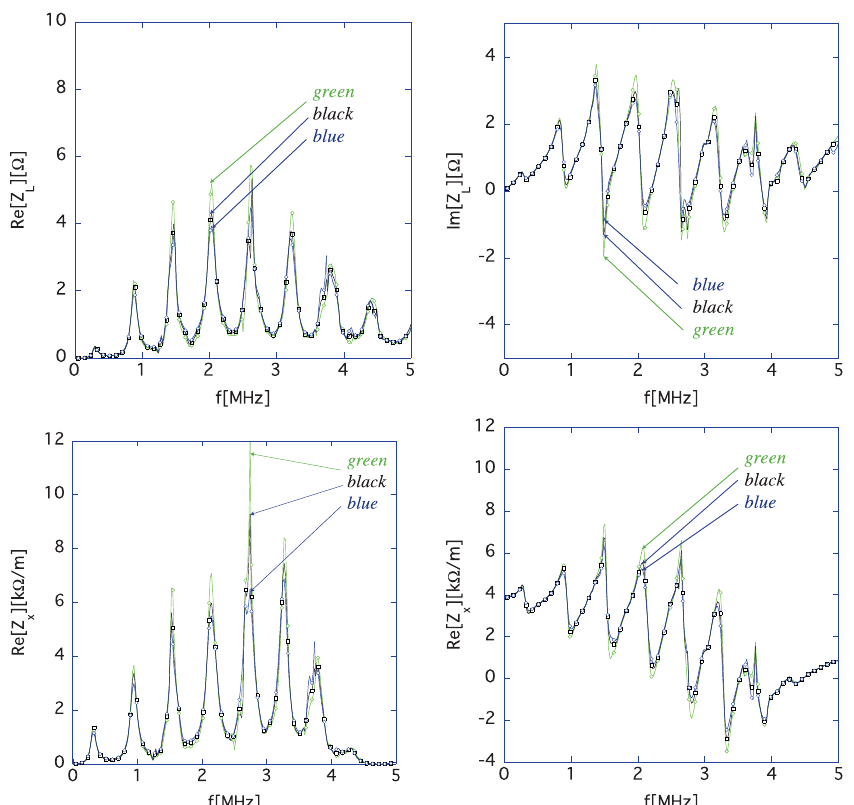
FIG. 15. Measurements of the longitudinal (upper row) and horizontal (lower row) beam impedances with beam-induced voltages and currents, where the diodes and resistors are installed. The green open circle, black square and blue diamond lines show the results for 1 . 245 × 10 13 (300 kW-eq), 2 . 075 × 10 13 (500 kW-eq), and 3 . 11 × 10 13 (750 kW-eq) particles per bunch, respectively. The left and the right columns show the real and imaginary parts of the beam impedances,